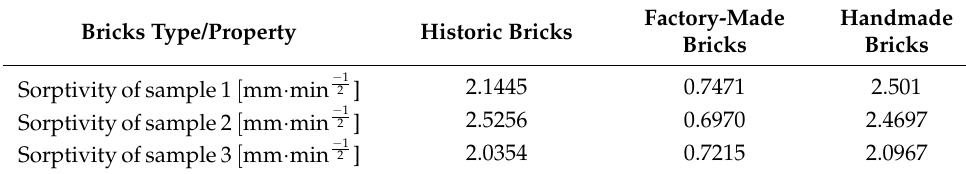
Table 1. Sorptivity results for particular brick samples.